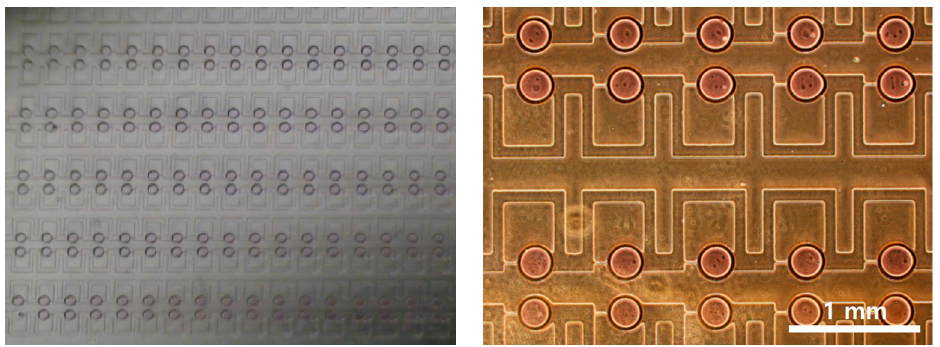
Figure 3. Optical images of arrayed water sample using parallel microfluidic device.